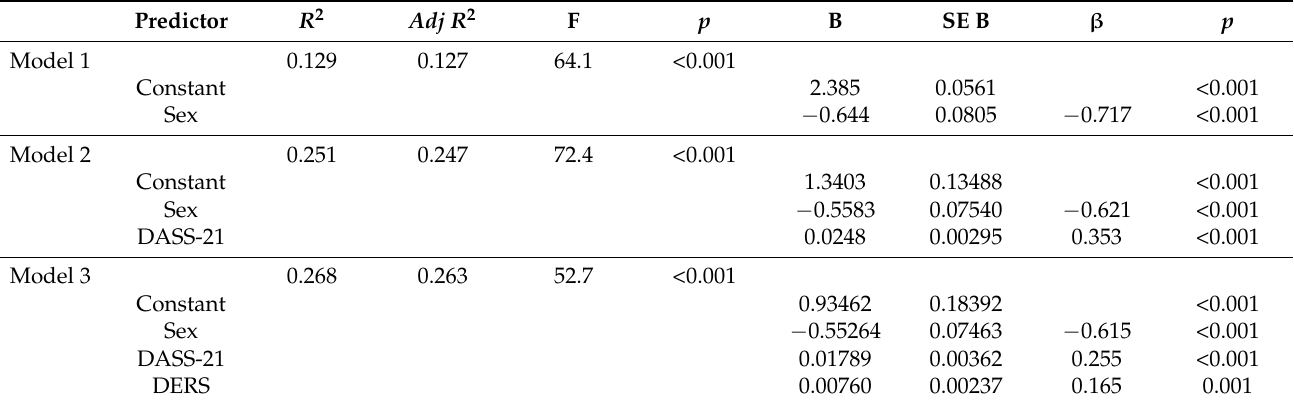
Table 3. Hierarchical multiple regression with emotional eating as a dependent